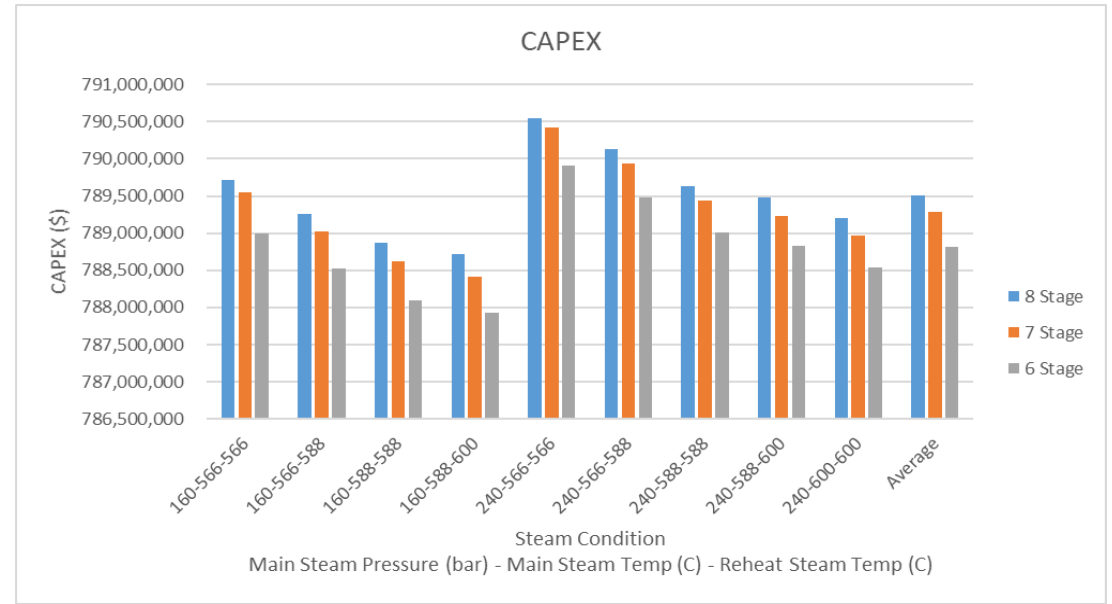
Figure 6. CAPEX average according to steam condition and heater stage.